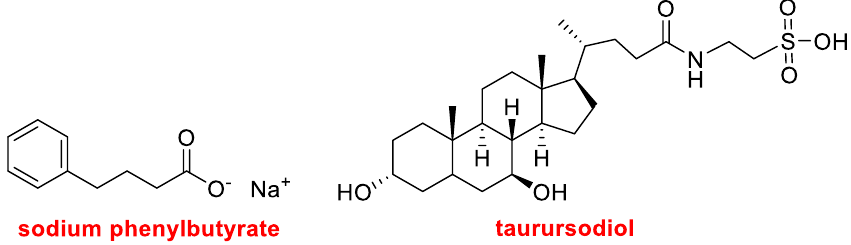
Figure 9. Structure of the components of the combination drug Relyvrio TM :.